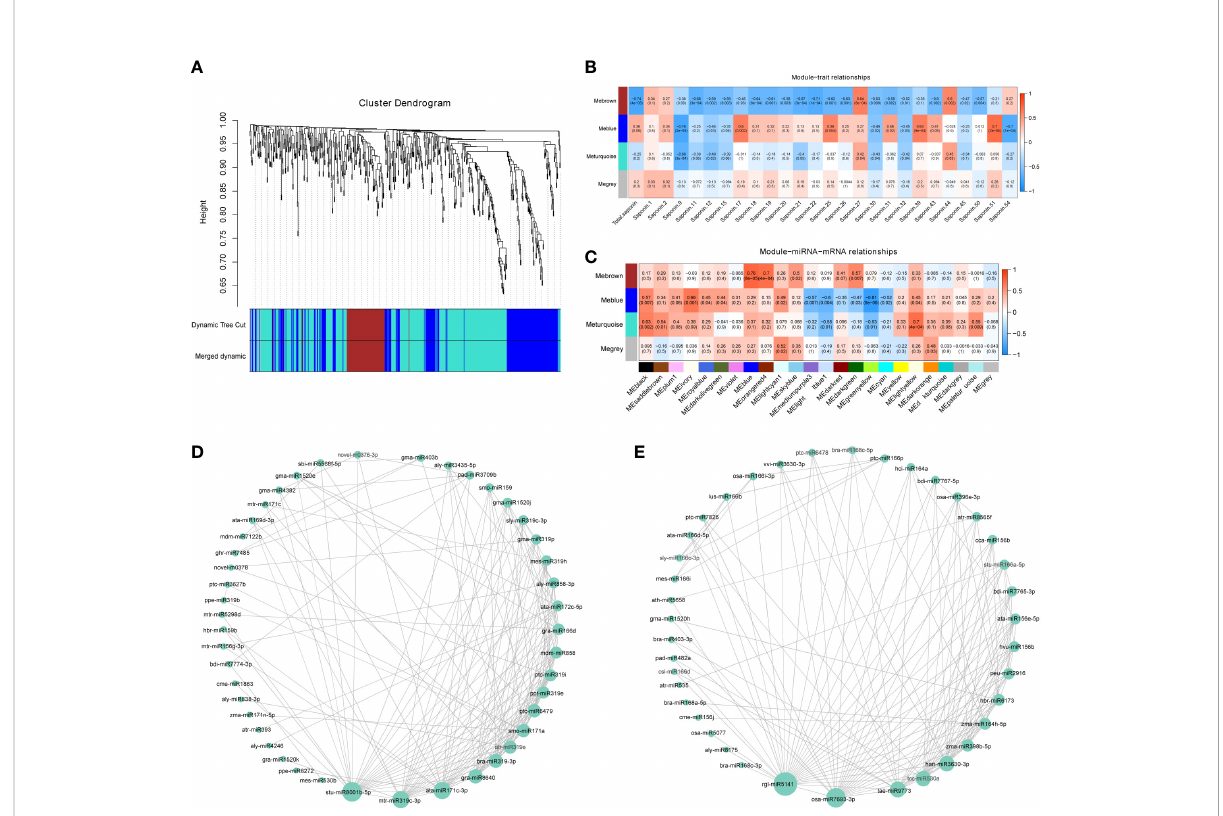
FIGURE 5 WGCNA of expressed miRNAs. (A) Hierarchical clustering tree (clusterdendrogram)showing fourmodules of coexpressedmiRNAsby WGCNA. Each leaf of tree corresponds toone miRNA. The major tree branches constitute fourmodules, labeled with different colors. (B) Module – saponin relationship. Eachrow represents a module. Eachcolumnrepresents a speci fi c saponin. The value in each cellat the row-columnintersection represents the correlation coef fi cient betweenthe moduleand the saponinand is displayed according to the color scaleonthe right.The value in parentheses in eachcellrepresents the P -value. (C) Correlation and P -values of miRNA modules eigengenes with mRNAs modules eigengenes from the same pericarpsamples in soapberry.The rowsrepresent miRNA modules and the columns represent mRNA modules. The correlation networksof miRNAsin the Mebrown (D) and Meblue (E) modules, in which onlyedges with weight above a threshold of 0.10 and 0.25 are displayed,